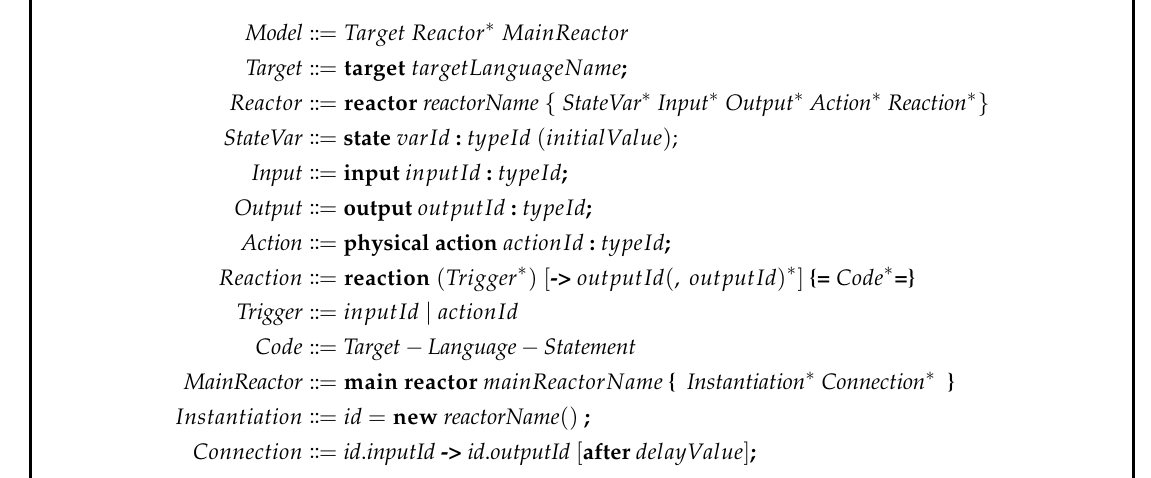
Figure 1. Syntax of a subset of Lingua Franca that we use in our examples in this paper (adapted from Lingua Franca Github [24]). The syntax is written in a slightly revised version of Extended BNF where instead of putting terminals in quotations we use words in “ bold ” format. Angled brackets (cid:104) ... (cid:105) are used as meta parenthesis, superscript + for repetition at least once, superscript ∗ for repetition zero or more times, whereas using (cid:104) ... (cid:105) with repetition denotes a comma separated list. Brackets [ ... ] indicates that the text within the brackets is optional. In the syntax, targetLanguageName, reactorName, mainReactorName stand for the target language for LF, the name of the reactor, and the name of the main reactor, respectively. The varId, typeId, inputId, outputId, actionId stand for the names of a variable, a type, an input and an output, respectively; and id stands for the name of an instance of a reactor. Target-Language-Statement stands for the statements of the target language. In the Reactor rule the components do not need to come in the presented